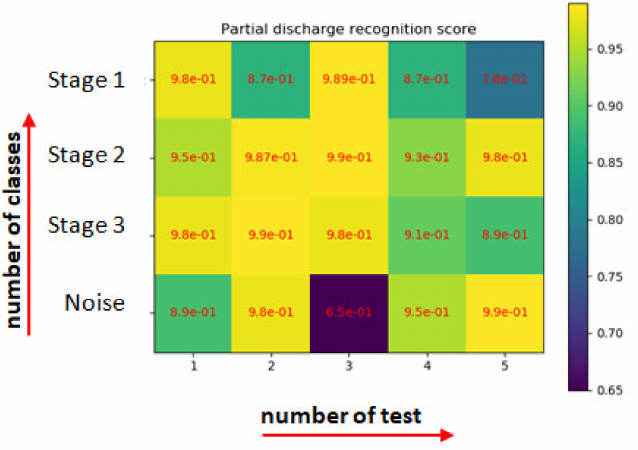
Figure 13. Recognition score array in PD monitoring example after 50 epochs using convolutional. neural network. According to the notation rows relate to the number of classes and columns to the number of test sets.